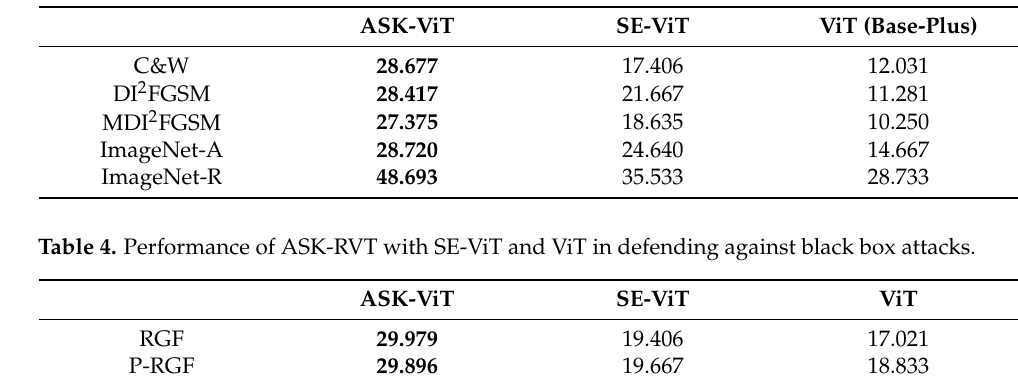
Table 3. Performance of ASK-RVT with SE-ViT in defending against white-box attacks.